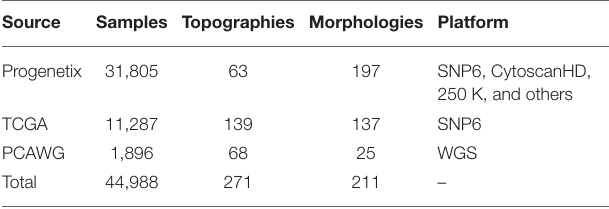
TABLE 1 | The data composition in the final dataset after quality filtering.